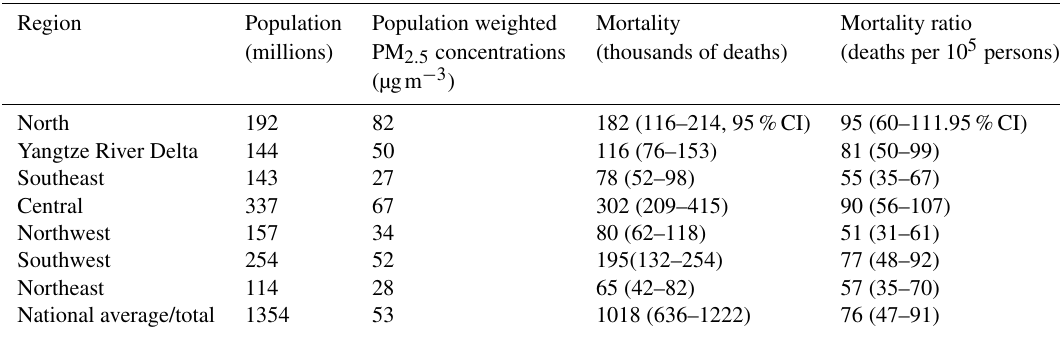
Table 1. Regional populations, PM 2 . 5 concentrations, mortality, and mortality ratios within China.